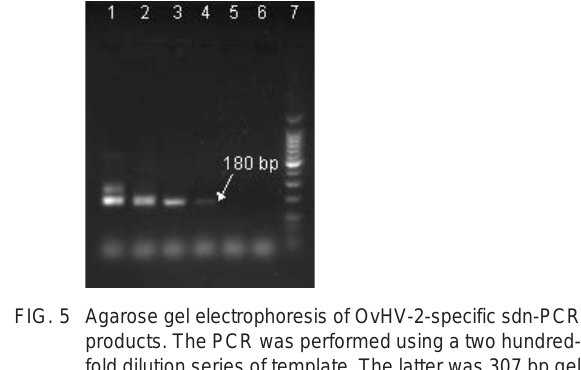
FIG. 5 Agarose gel electrophoresis of OvHV-2-specific sdn-PCR products. The PCR was performed using a two hundred- fold dilution series of template. The latter was 307 bp gel purified PCR amplicons obtained by performing MCFV- PCR on DNA extracted from an OvHV-2-infected bovine. Indicated are PCR products derived from 80 pg, (lane 1); 0.4 pg (lane 2), 2 fg (lane 3), 0.01 fg (lane 4) and 0.05 ag (lane 5) starter amplicons as well as a neg-